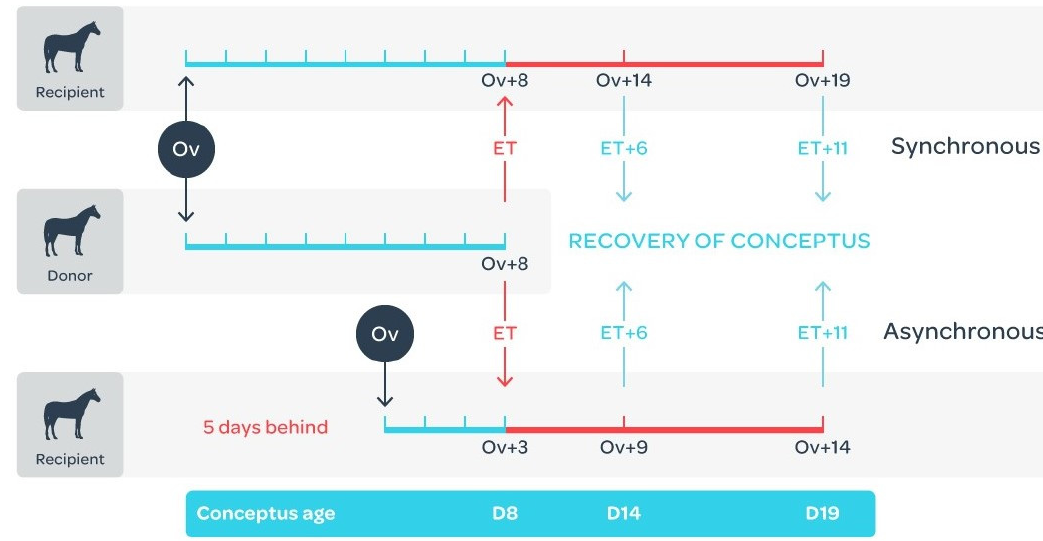
Figure 9. Day 8 embryos were transferred to recipient mares that ovulated on the same day (synchronous: n = 10) or 5 days after (asynchronous: n = 10) the donor mare. Conceptuses were recovered 6 or 11 days later (5 per group), when the conceptus would be at either 14 or 19 days of development and the recipient mares would be at either 9, 14 or 19 days after ovulation. Adapted from